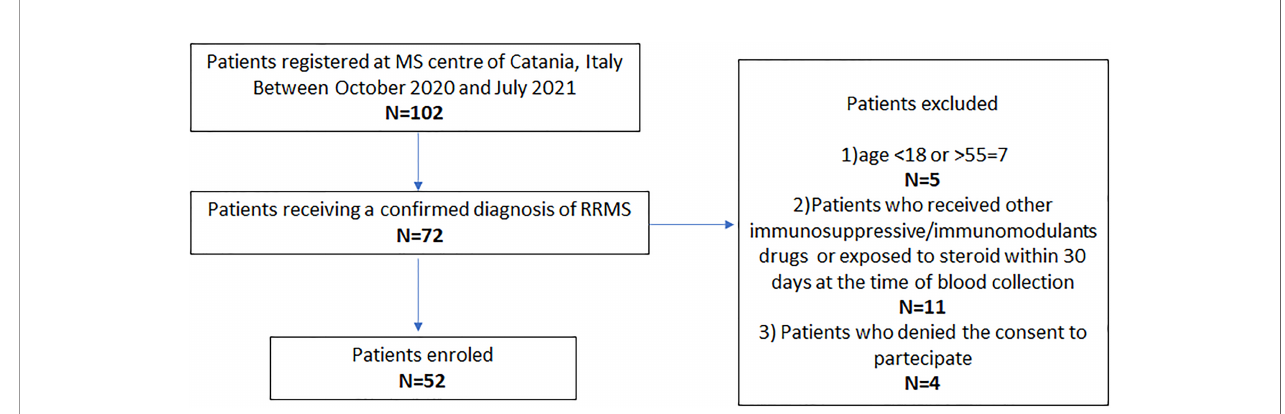
FIGURE 1 | Study fl ow chart. DMTs, disease-modifying therapies; MS, multiple sclerosis; RRMS, relapsing – remitting